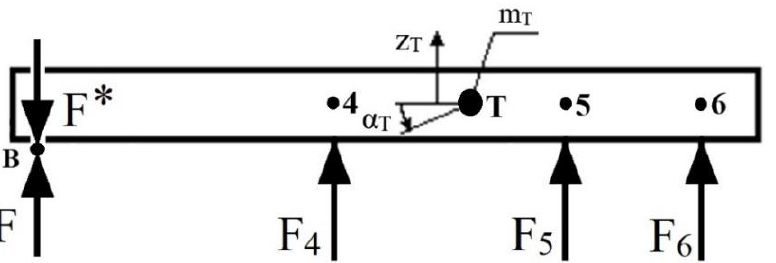
Figure 6. Diagram used to calculate the vertical force F on the joint between the tractor’s fifth wheel and the kingpin of the semitrailer. F is the force exerted by the fifth wheel on the semitrailer and F* = − F is the force exerted by the semitrailer on the fifth wheel.